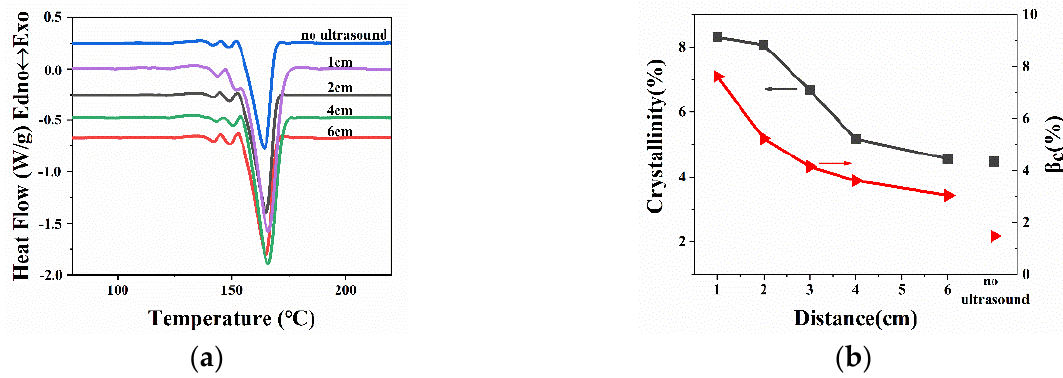
Figure 8. ( a ) The melting behaviors of WBG-PP at different ultrasound distances. ( b ) Effect of the ultrasound distance on the values of relative content of the β -crystal form ( β c ) and crystallinity ( θ ). Table 2. The β c and θ values of WBG-PP at different ultrasound distances.